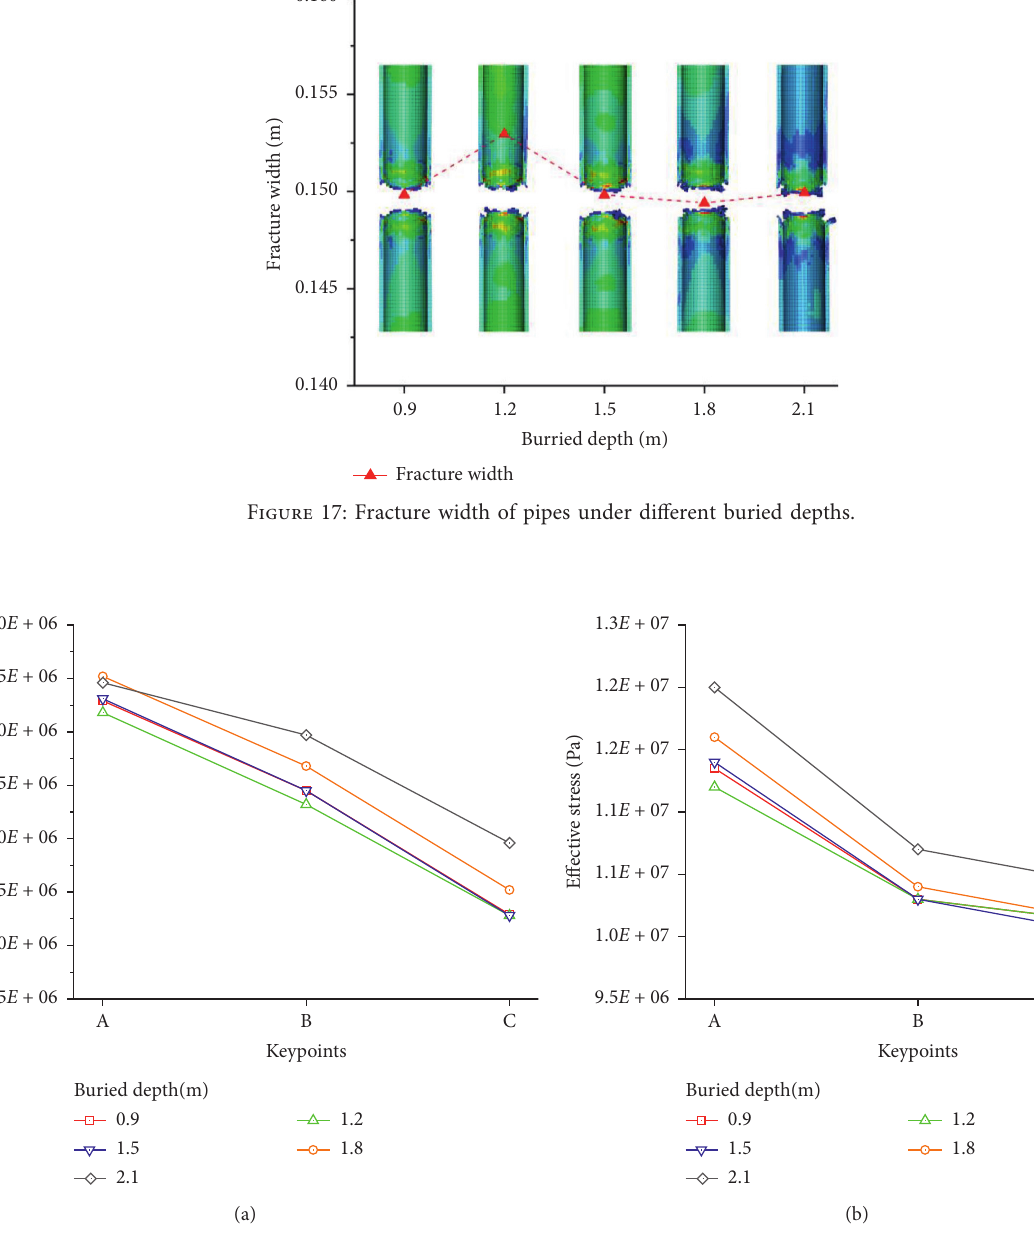
Figure 18: The maximum pressure and effective stress of pipes under different buried depths.